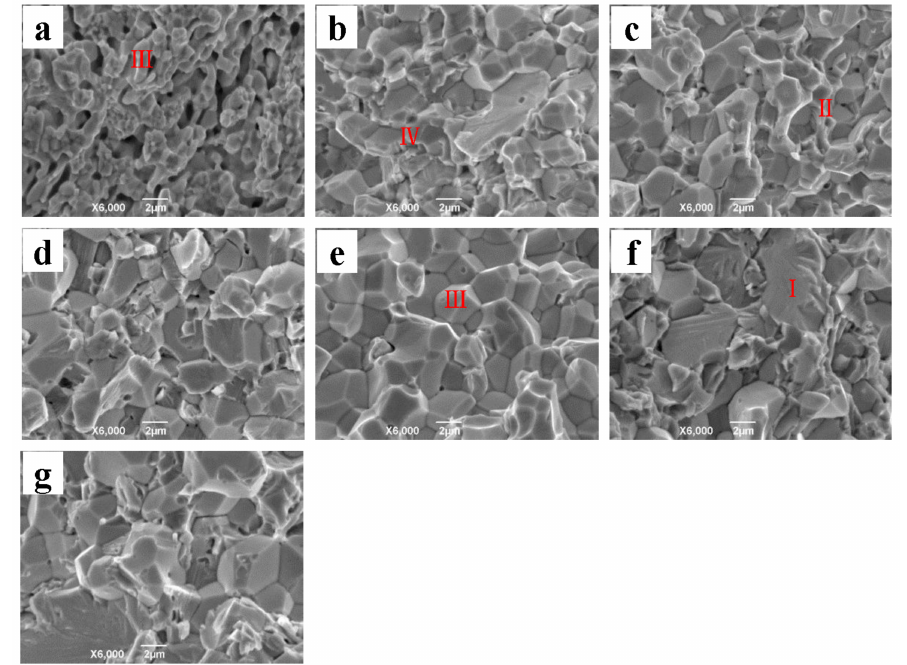
Figure 11. Fracture morphology for flexural testing of W-6Ni-4Co alloys by the di ff erent sintering processes: ( a ) 1200 ◦ C, 30 min; ( b ) 1450 ◦ C, 5 min; ( c ) 1450 ◦ C, 20 min; ( d ) 1450 ◦ C, 60 min; ( e ) 1500 ◦ C, 5 min; ( f ) 1500 ◦ C, 20 min; ( g ) 1500 ◦ C, 60